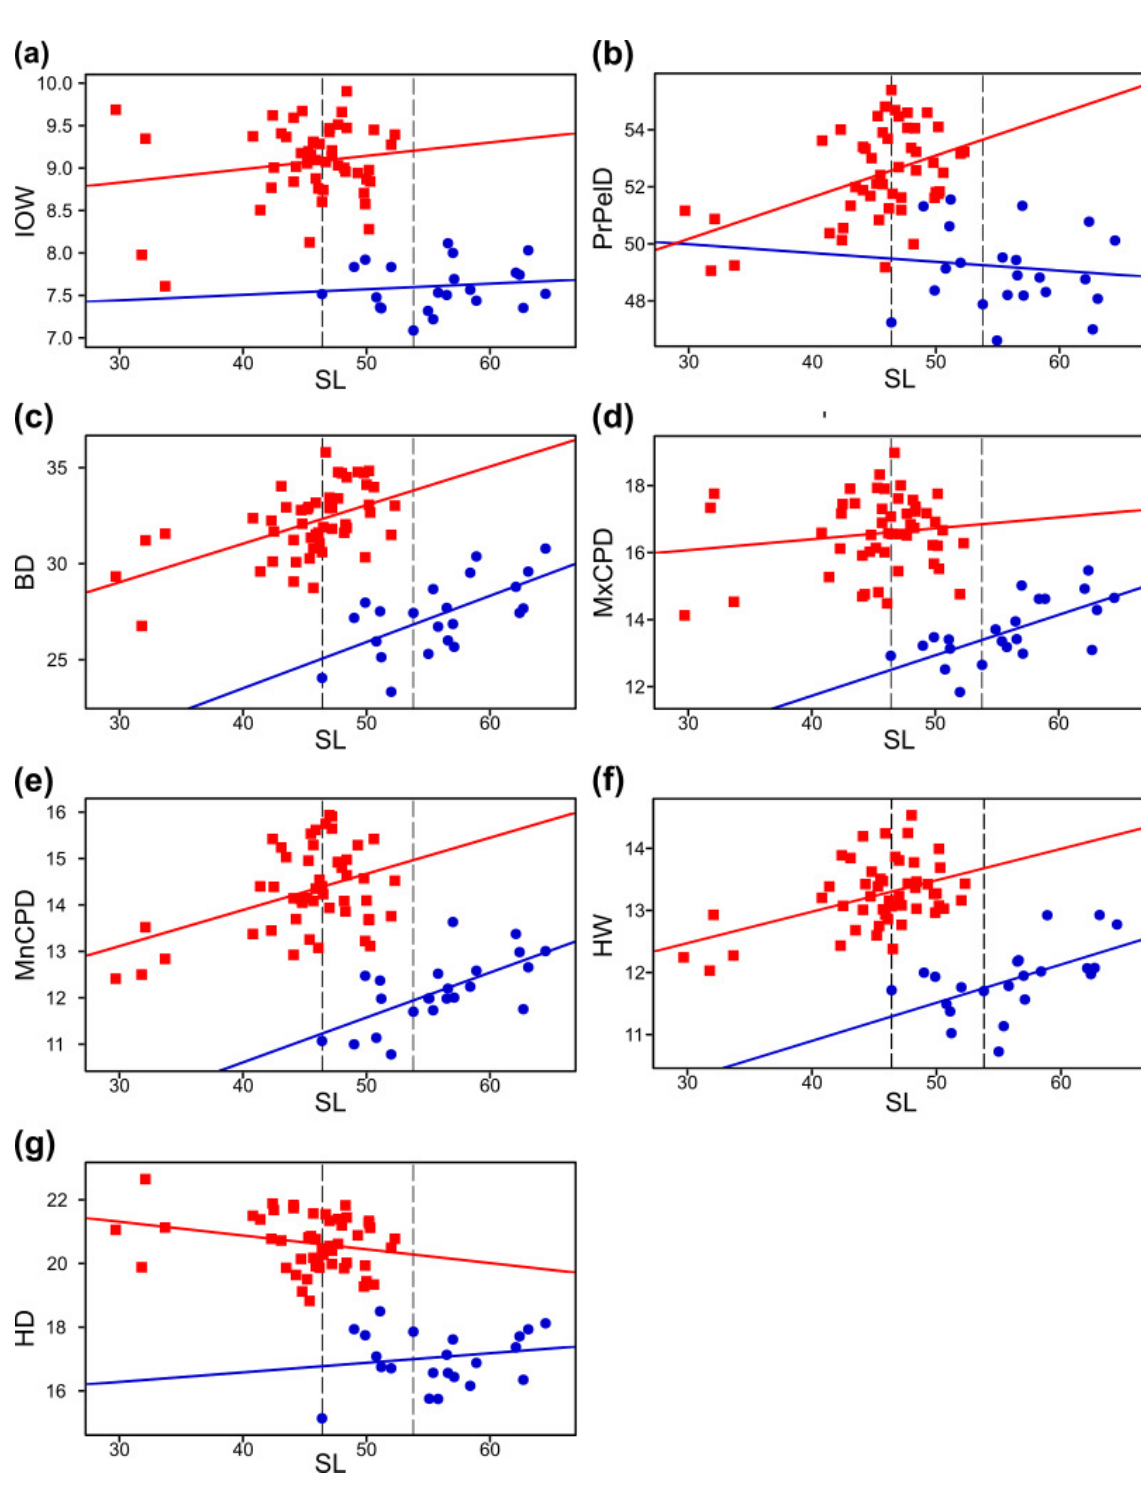
Fig. 3. Scatterplots of (a) interorbital width (IOW), (b) pre-pelvic distance (PrPelD), (c) body depth (BD), (d) maximum caudal peduncle depth (MxCPD), (e) minimum caudal peduncle depth (MnCPD), (f) head width (HW), and (g) head depth (HD) in % SL against SL (in mm) on 72 specimens of Enteromius Cope, 1867. The genetic groups A (●) (n = 22) and B (■) (n = 50) are indicated separately. The dashed lines indicate the size class used for the MWU